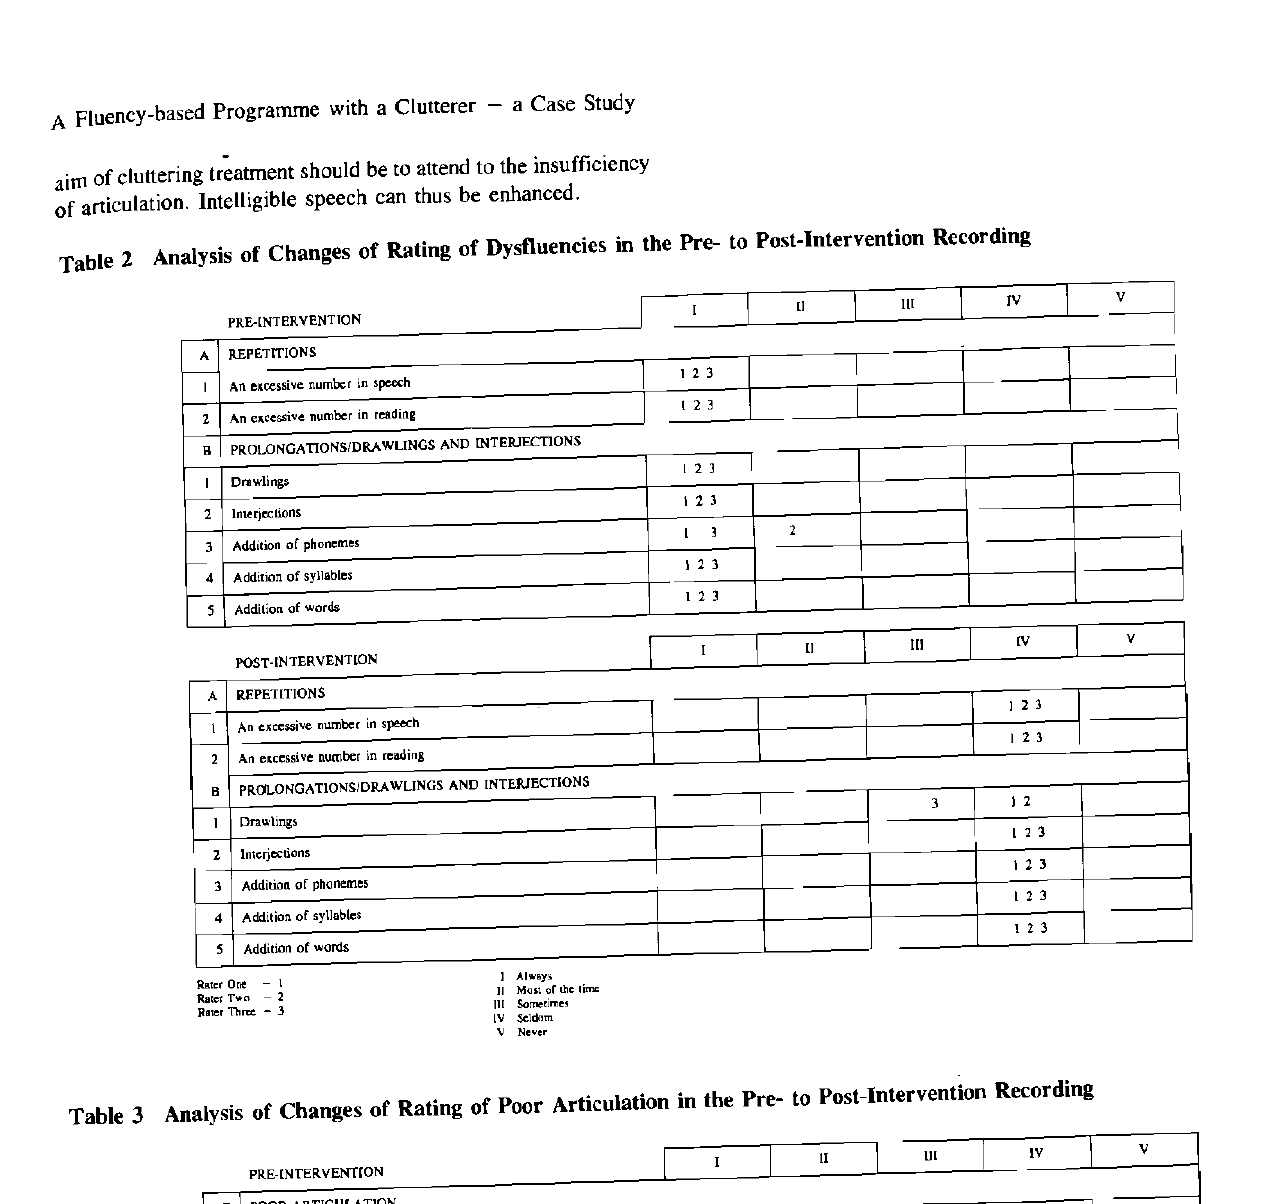
Table 3 Analysis of Changes of Rating of Poor Articulation in the Pre- to Post-Intervention Recording